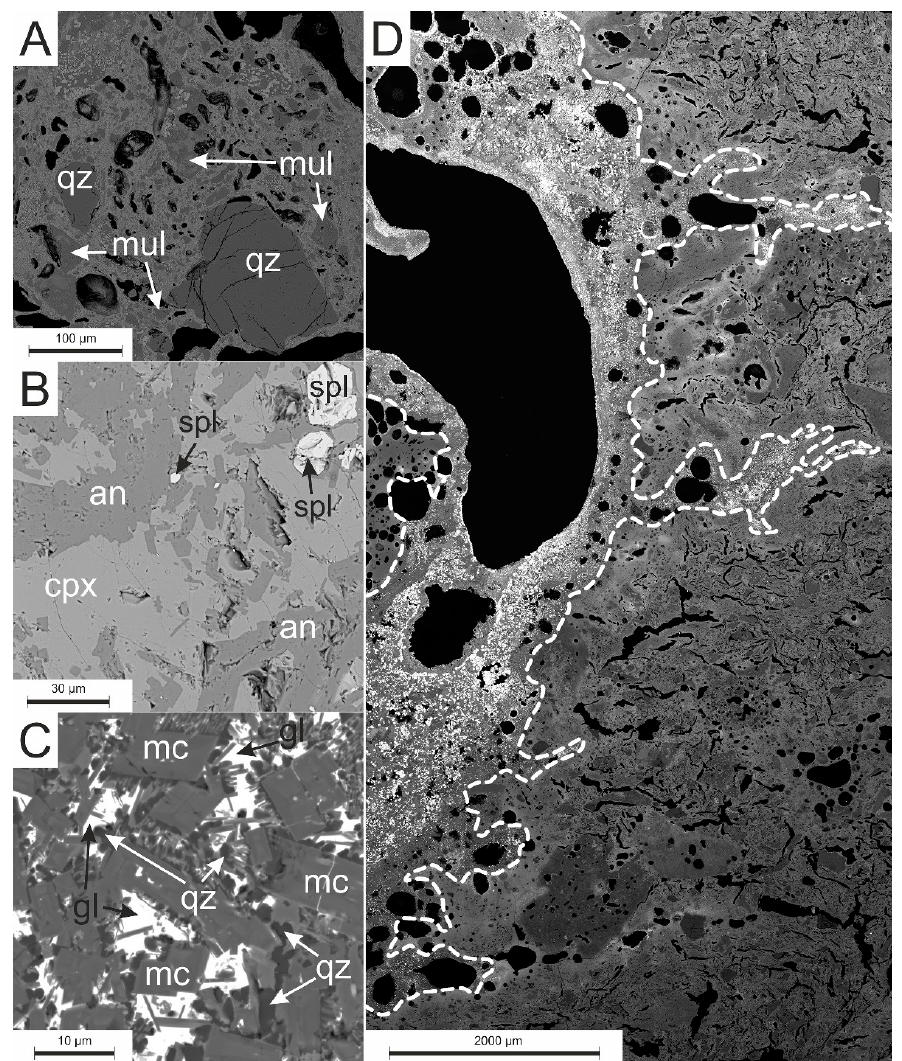
Figure 4. BSE (Backscattered Electrons) image of: ( A ) refractory material, ( B ) slag, ( C ) the contact zone of the slag with the refractories, ( D ) the intrusion of slag melt (left side of the dotted line) within refractory material (right side). Abbreviations: an—anorthite, cpx—clinopyroxene, gl—glass, mc—microcline, mul—mullite, spl—spinel,